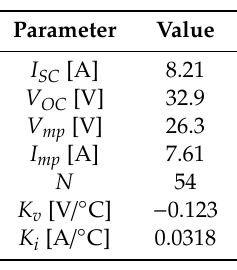
( a ) ( b ) Figure 5. I–V curves for the module KC200GT at different solar irradiance ( a ) and temperature ( b ) of the proposed method. In order to validate the proposed method, the experimental data provided by datasheets are used. Nevertheless, the I–V curves in the datasheet are not in a tabular format, and data must be extracted. Therefore, using the tools available in [60], the curves are digitalized and transferred on a spreadsheet. However, the data extracted from the curves are different from those declared in the tables of the datasheet because these values have a declared tolerance. To get a more accurate estimation of the parameters, the newly extracted data of the I–V curve in STC from the datasheet’s image is used. The proposed method is tested both with datasheet values and curves. Table 2 shows the comparison results of some examined works and the proposed method. The parameter values of [40,43,41,44] were taken by [47], which were extracted from the datasheet curves. In [48], there are